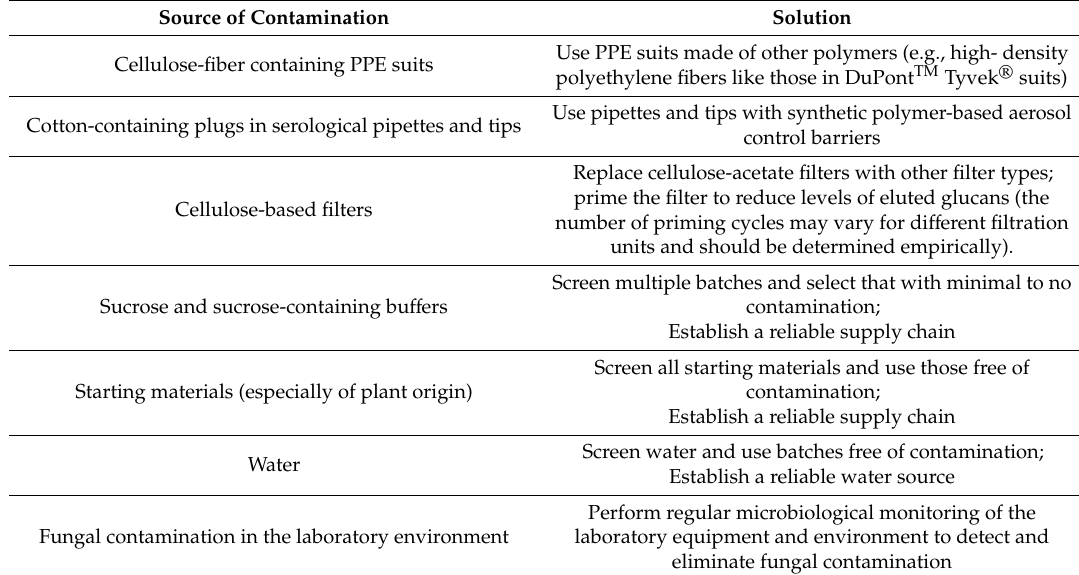
Table 2. Common sources of beta-glucan contamination in pharmaceutical products and solutions for avoiding contamination . Assays, such as Glucatell, could be used by individual laboratories to validate materials, procedures, and environments to minimize contamination. PPE = personal protective